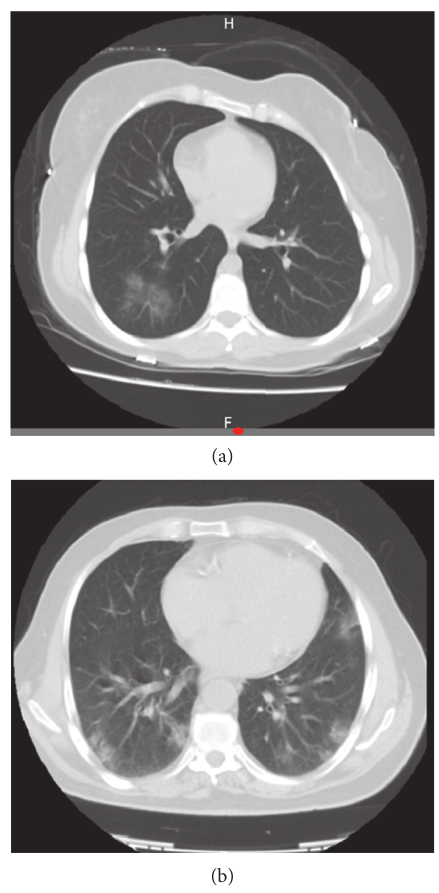
Figure 1: (a) Ground-glass opacities in two different cases of COVID-19 in an early stage. (b) Ground-glass opacities in two different cases of COVID-19 in an early